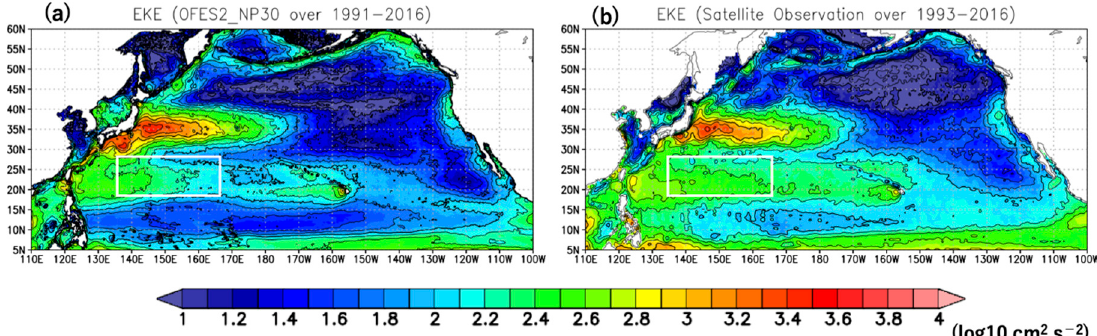
Figure 1. Eddy kinetic energy (EKE) (log 10 cm 2 s − 2 ) estimated from the geostrophic currents of sea surface height (SSH) anomalies in the North Pacific based on ( a ) OGCM for the Earth Simulator version 2 (OFES2)_NP30 averaged over 1991–2016 and ( b ) satellite observations from AVISO (https://www.aviso.altimetry.fr) averaged over 1993–2016. The Subtropical Countercurrent (STCC) region (box region) is defined by the box region from 135° E to 165° E between 18° N and 28° N.